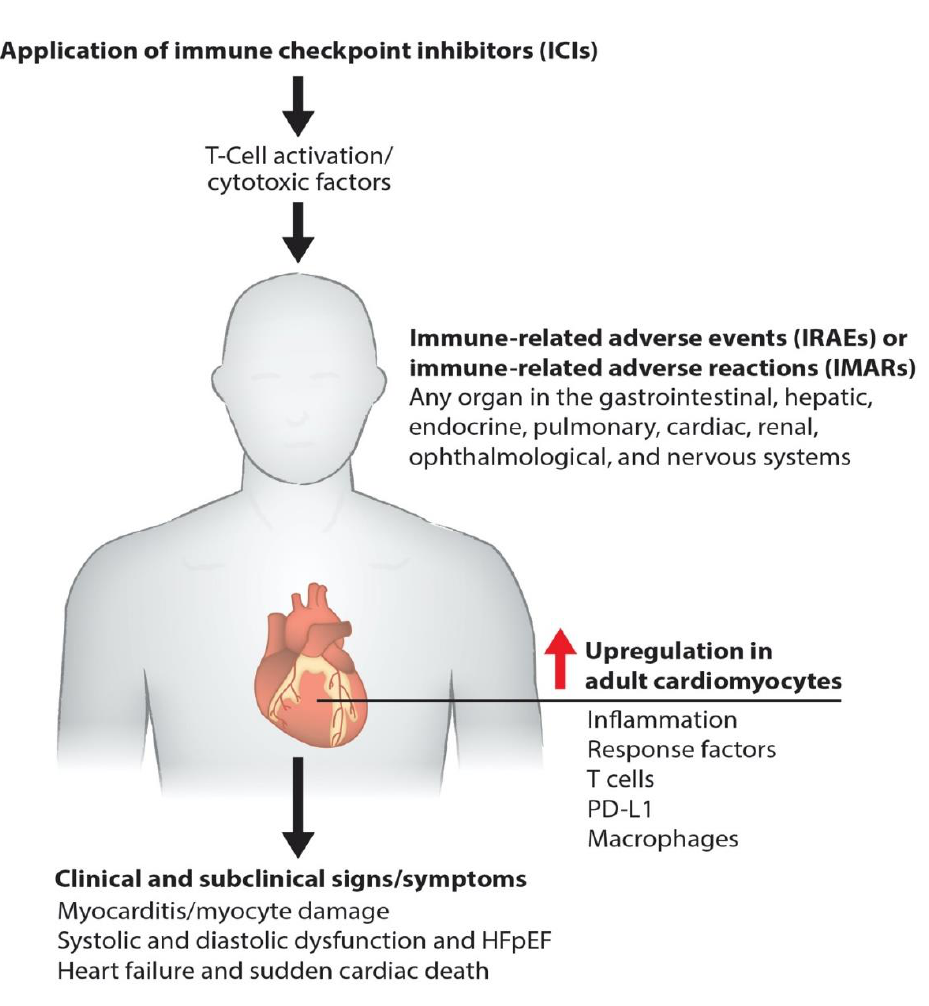
Figure 1. Molecular pathogenesis of immunotherapy-induced cardiac toxicity. Schematics describe how the ICIs such as anti-PD-1, anti-PD-L1, and anti-CTLA-4 promote myocarditis via cardiac inflammation, causing myocyte damage. Cardiac myocyte dysfunction impairs systolic and diastolic function and causes failure and death.